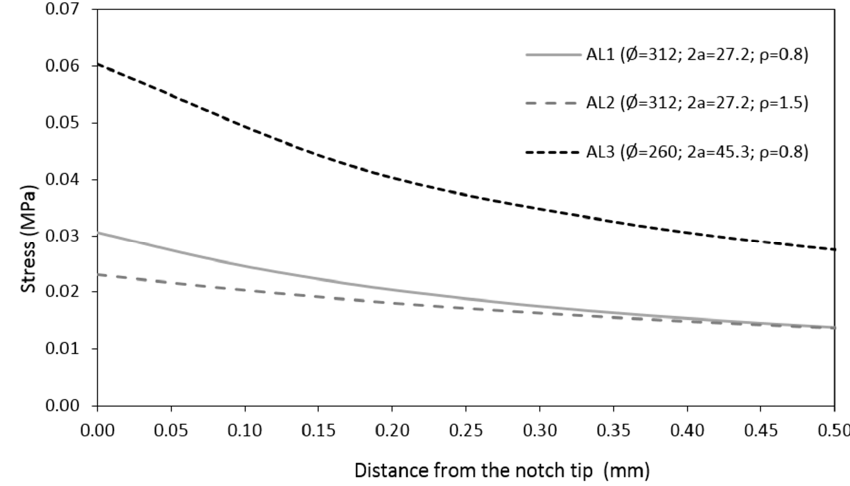
Figure 11. Stress–distance curves in tubular beams when applying a unit load (1 N) at the free end.